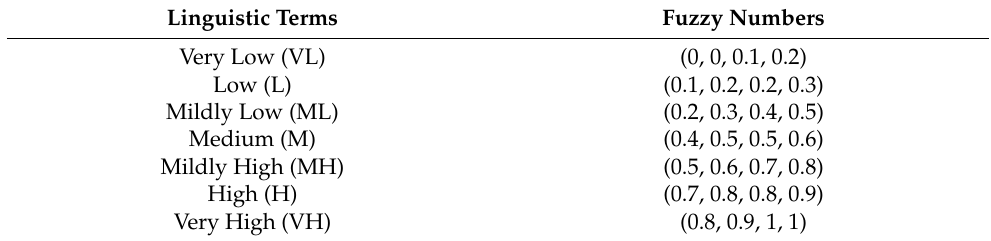
Table 8. Fuzzy number sets of the scale.